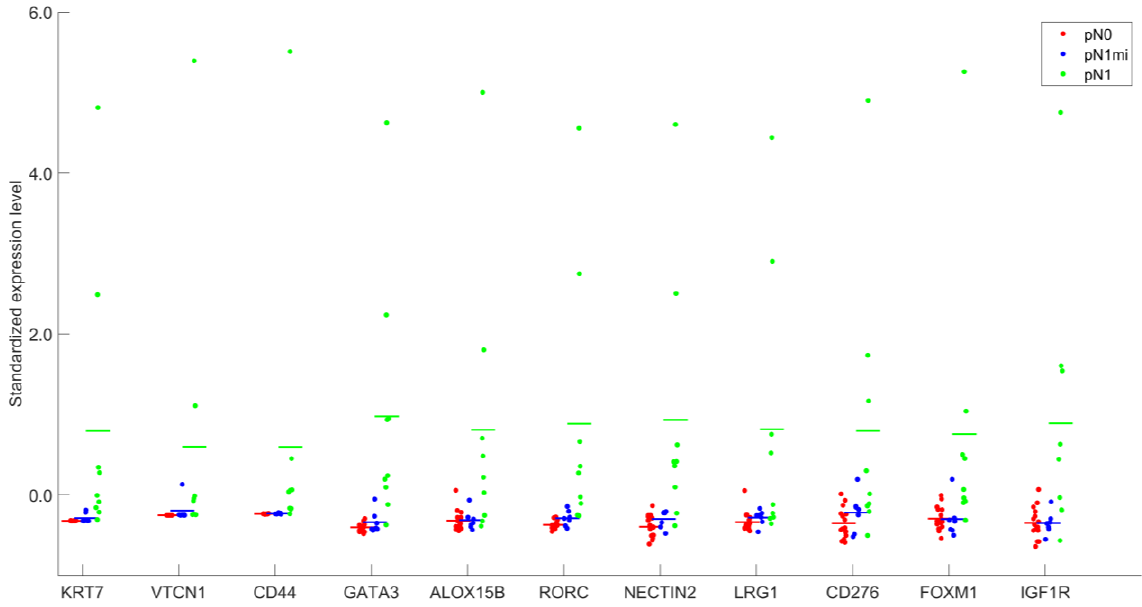
Figure 3. Standardized expression levels after DESeq2 normalization of the 11 genes identified as differentially expressed, for groups pN0, pN1mi and pN1.